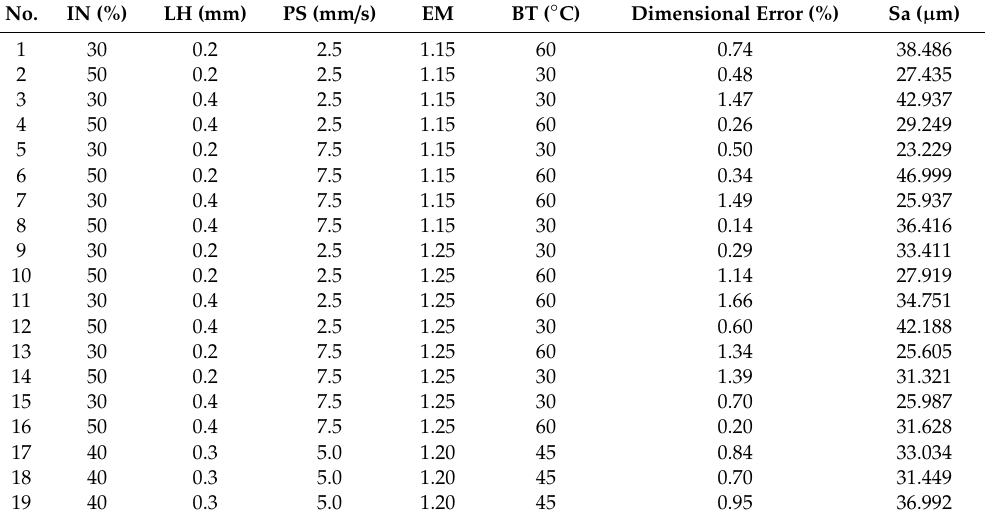
Di ff erent surface topographies were obtained on the lateral walls of the prismatic shapes. As an example, Figure 2 shows the surface topographies of samples 5 and 10.